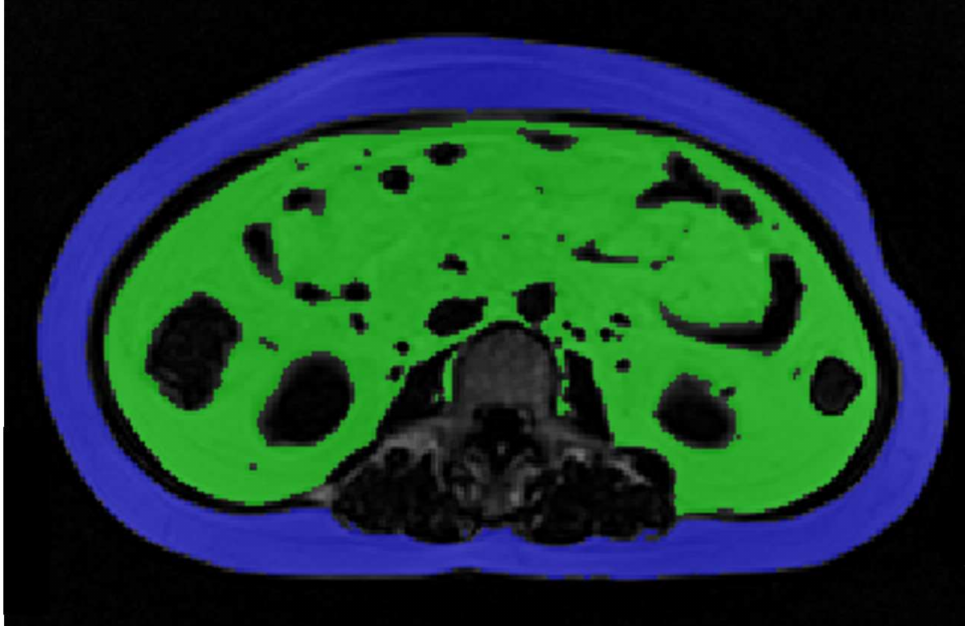
Figure 1. Slice at the level of the third lumbar vertebra, images acquired from the participant with unusually high levels of VAT (green color). SAT is shown in blue. Abbreviations: SAT: Subcutaneous adipose tissue, VAT: Visceral adipose tissue.